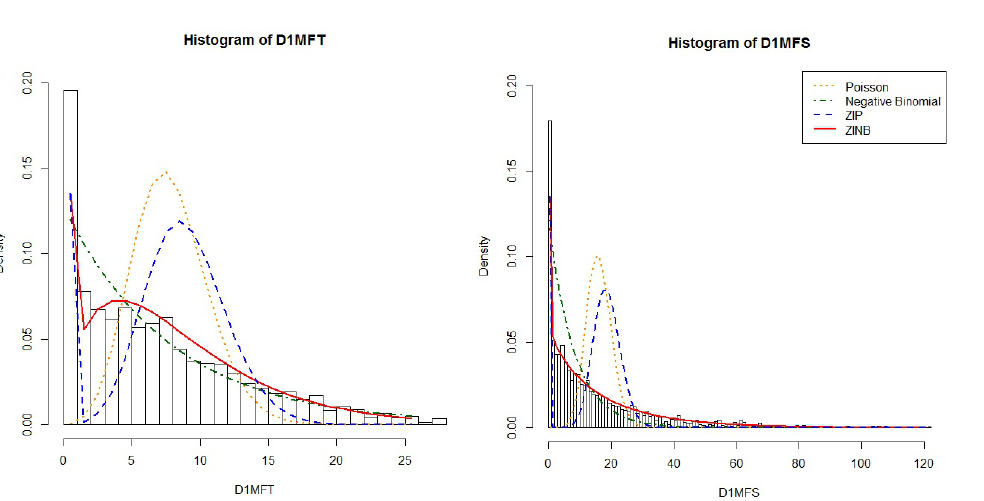
Figure 8. Histograms and fitted densities for traits D1MFT and D1MFS in dental caries